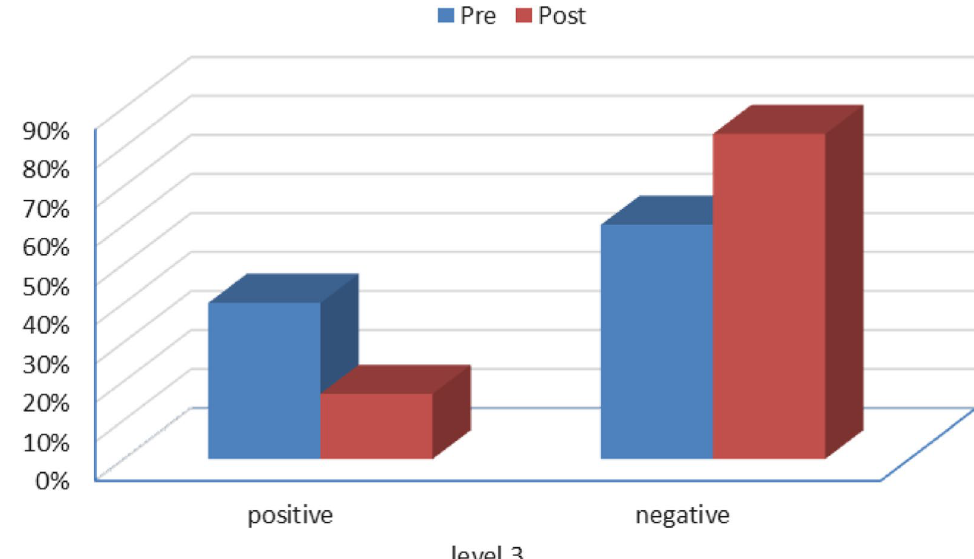
Fig. 5 Bar graph representing the mean of LPA in both successful and unsuccessful groups before and after surgical intervention